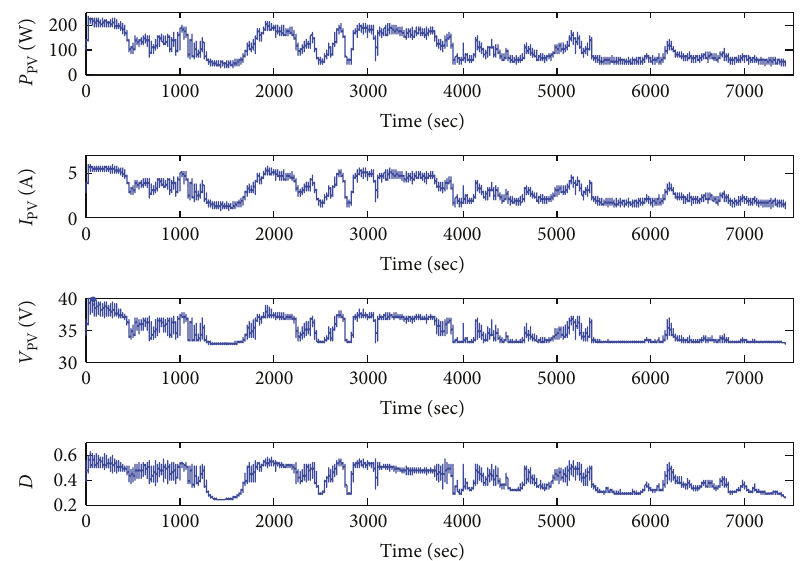
Figure 23: Experimentally tracking behavior of the ANFIS MPPT. From 12:56PM to